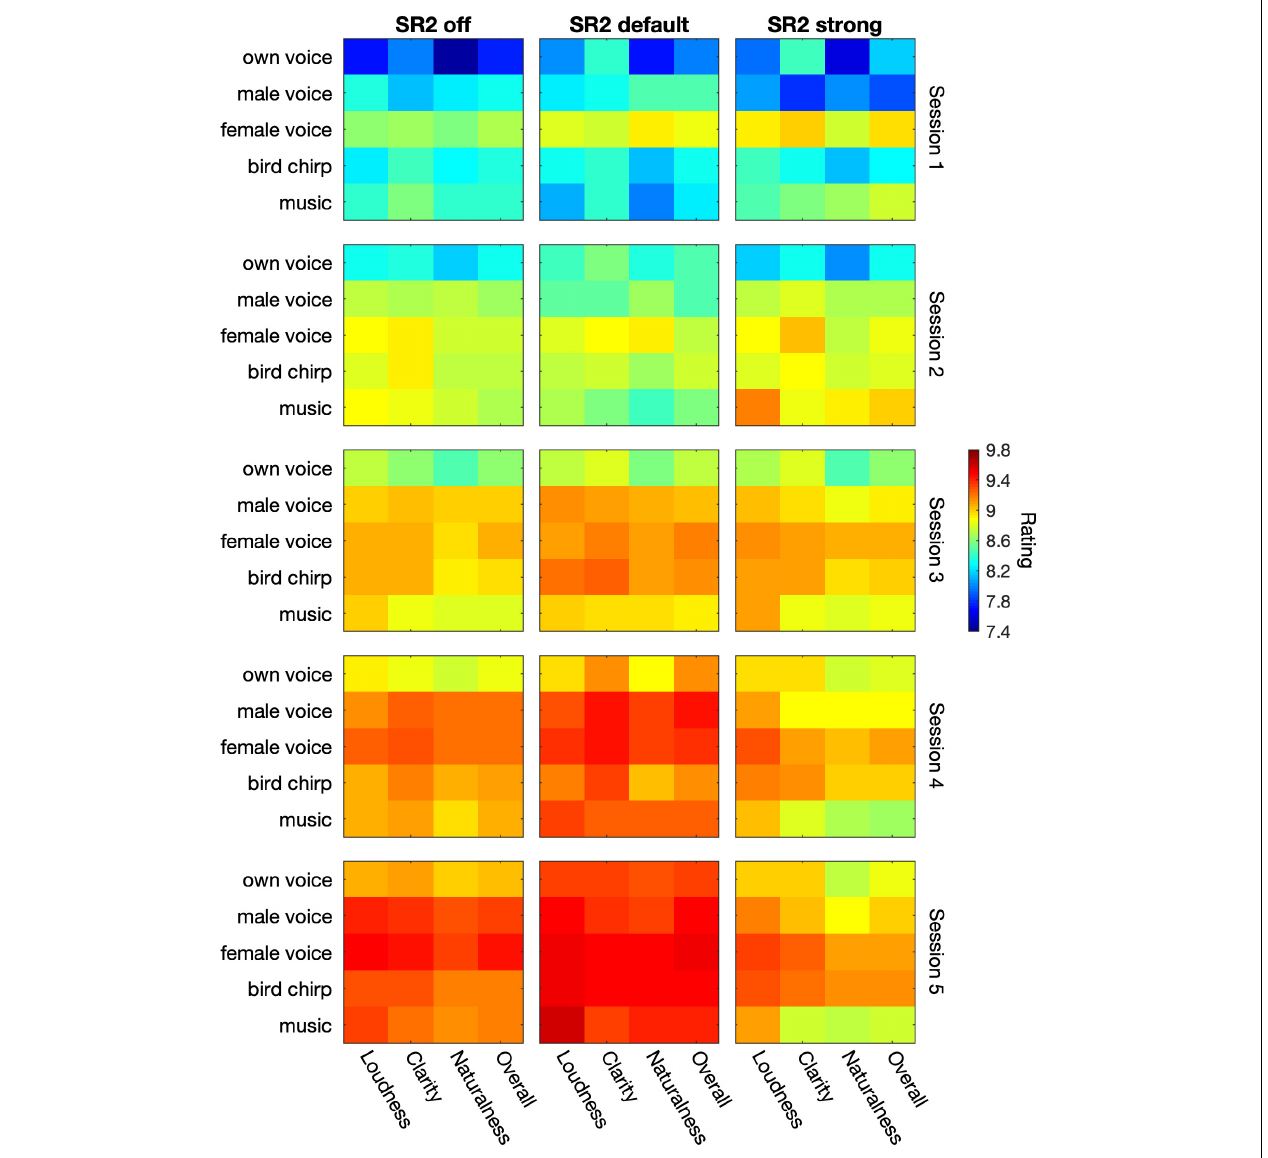
FIGURE 8 | The average sound-quality ratings from the 29 participants. The three columns represent SR2 off, SR2 default, and SR2 strong setting, respectively. From top to down, the 5 rows indicate the 5 sessions. In each panel, the five types of stimuli (i.e., own voice, male voice, female voice, bird chirps, and music) are represented in rows whereas the category of percepts (i.e., loudness, clearness, naturalness, and overall quality) are represented in columns. The color in each cell represents the rating score as indicated by the color bar on the